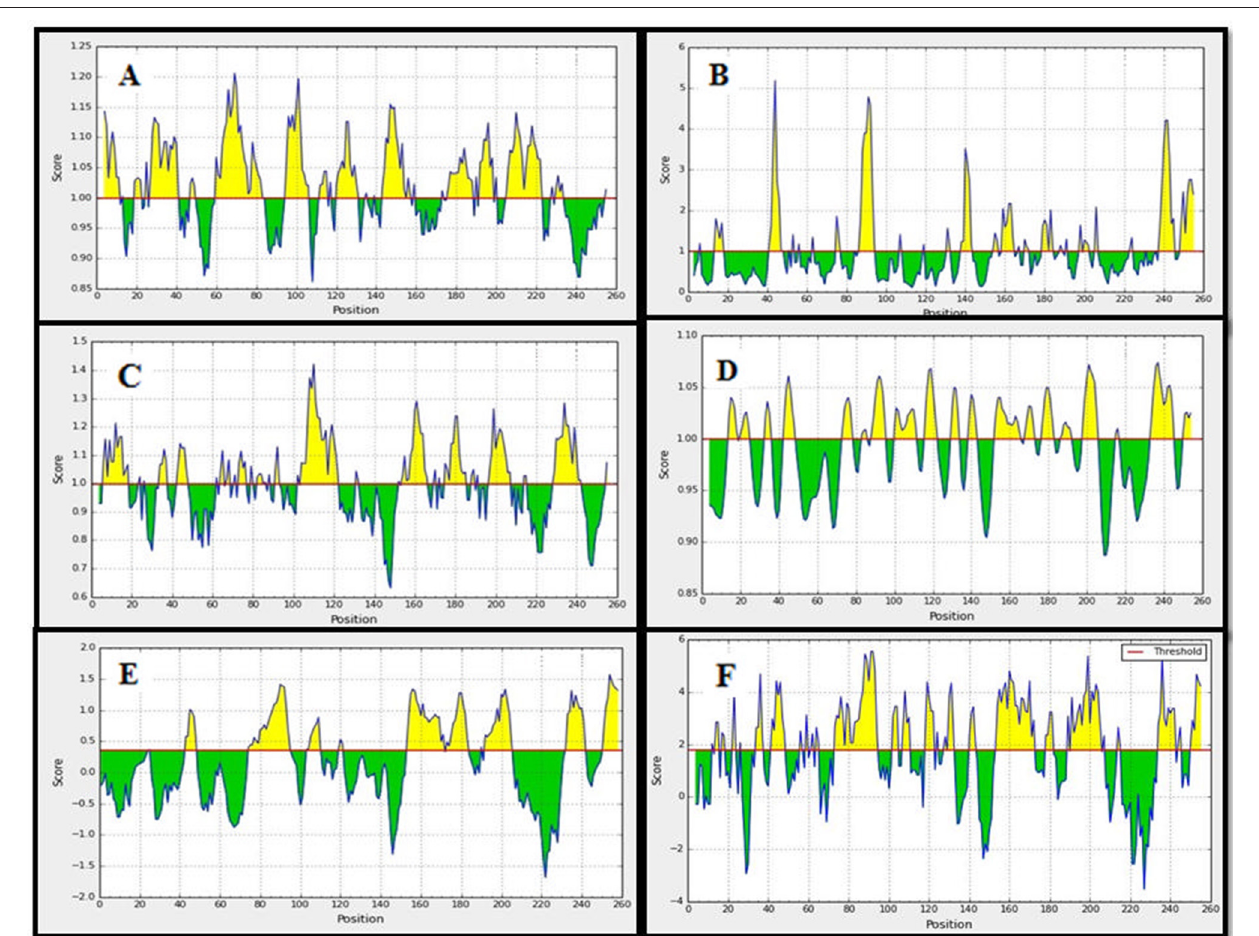
FIGURE 4 | Prediction of B-cell antigenic properties for most antigenic conserved region. Epitope ITPSAPSYT (176–184) showed all the antigenic criteria to be predicted as B-cell epitope. (A) Kolaskar and Tongaonkar antigenicity prediction. (B) Emini surface accessibility prediction. (C) Chou and Fasman beta-turn prediction. (D) Karplus and Schulz flexibility prediction. (E) Bepipred linear epitope prediction. (F) Parker hydrophilicity prediction. The x-axis and y-axis represent the sequence position and corresponding antigenic properties score, respectively. The threshold level is 1.0 for most of the properties except for (E) (0.40) and (F) (0.1772). The regions having antigenic properties are shown in yellow color above the threshold